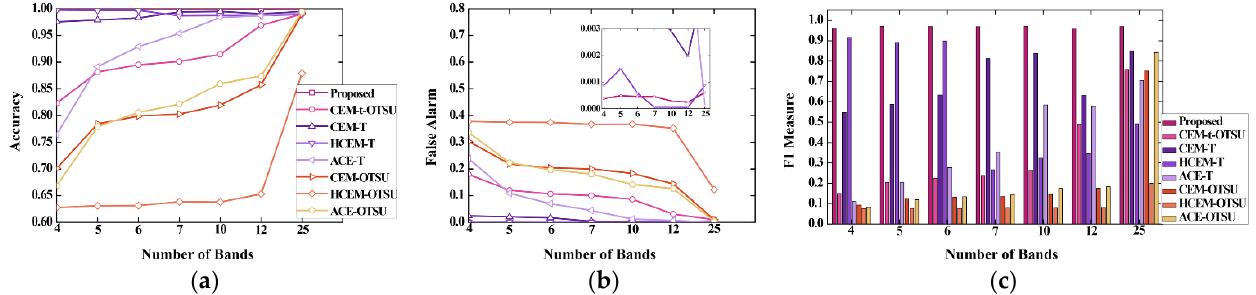
F using different methods; ( c ) The histograms of a